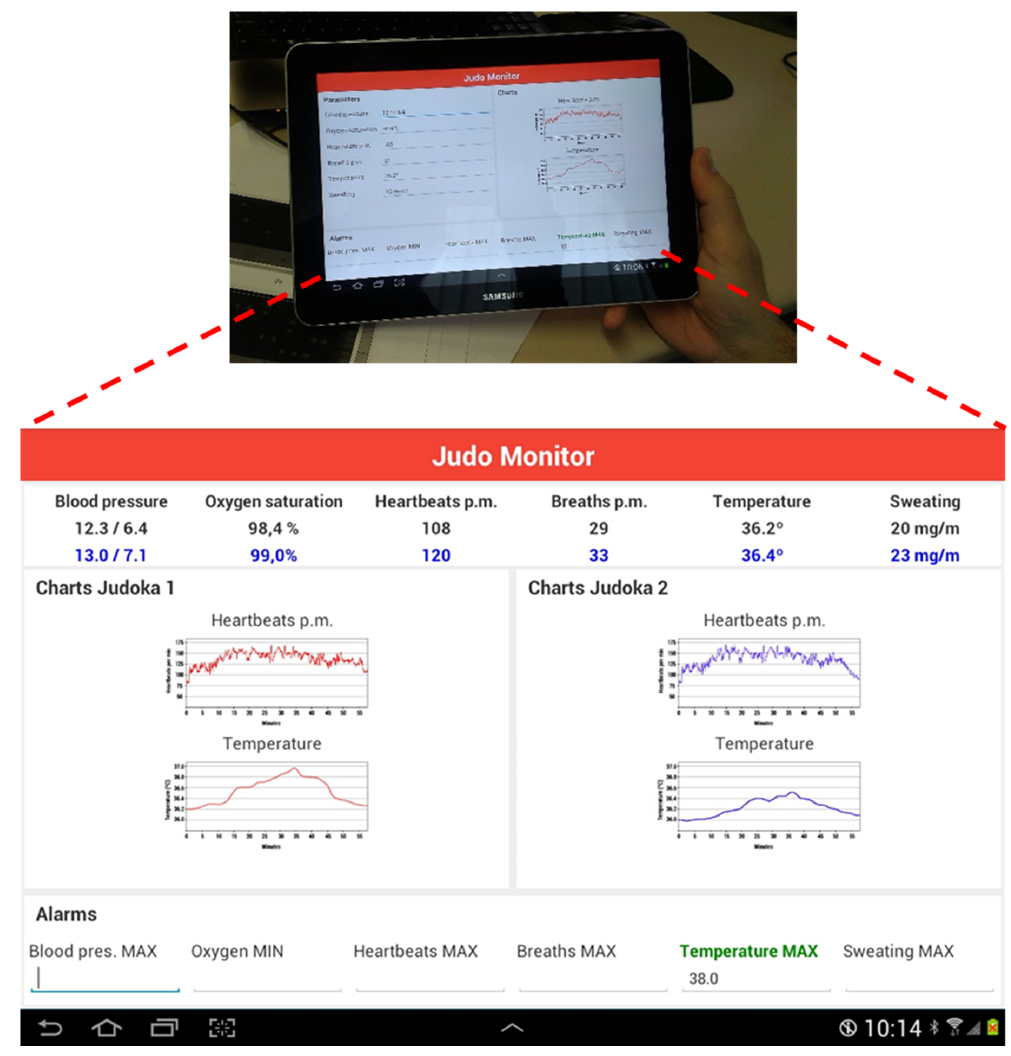
Figure 21. View of the presented monitoring app running in a tablet. The single (on the tablet’s screen) and dual (zoomed) monitoring of a randori are represented.